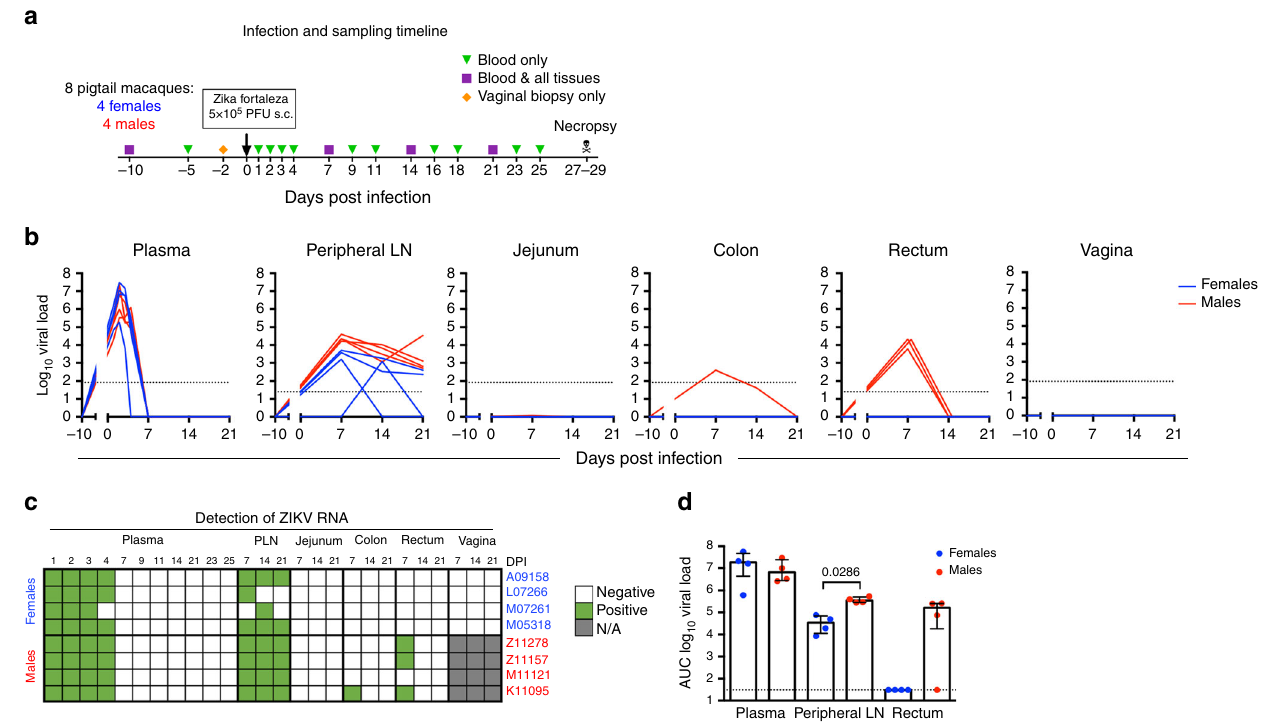
Fig. 1 Viral persistence in LNs and viral dissemination to mucosal tissues are greater in male PTMs. a Eight pigtail macaques ( n = 4 females, n = 4 males) were subcutaneously (s.c.) infected with 5 × 10 5 plaque-forming units (PFU) of a Brazilian Fortaleza isolate of ZIKV. Blood was routinely collected at 10 and 5 days prior to infection ( − 10 and − 5 dpi), daily for the fi rst 4 days post-infection, and then every 2 – 3 days until necropsy at 27 – 29 dpi. In addition to blood draws, comprehensive biopsy samples of the gastrointestinal tract (jejunum, colon, and rectum) and whole lymph nodes (peripheral) at − 10, 7, 14, and 21 dpi were taken. Vaginal biopsies were also sampled 2 days prior to infection ( − 2 dpi) and 7, 14, and at 21 dpi. b Kinetics of ZIKV RNA levels in the plasma (Log 10 copies/ml) and various tissues (Log 10 copies/mg) were determined by RT-qPCR. Dotted line indicates the limit of detection: 83 copies/ml or mg in plasma, jejunum, colon, and vagina or 25 copies/mg in the peripheral lymph node and rectum. c ZIKV distribution in plasma, peripheral lymph node (PLN), and mucosal tissues at 0 – 25 days post-infection (DPI) (plasma) or 0 – 21 dpi (PLN, mucosal tissues) is shown as follows: ZIKV RNA positive (green), negative (white), or tissue not available (N/A) (gray). d ZIKV burdens were determined by measuring area under the curve (AUC) in plasma (0 – 25 dpi), PLN, and rectum (0 – 21 dpi) in female (blue) and male (red) animals. Dotted lines indicate the limit of detection (31 copies/ml or mg) of the AUC. Dots are individual animals (total n = 8) and bars are the medians with interquartile ranges. Signi fi cant (unadjusted Wilcoxon p ≤ 0.05) p -values are